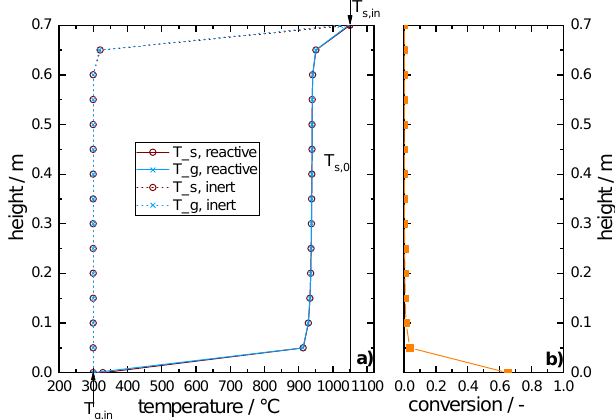
Figure 5. Results for a moving bed with 4g/s Mn-Fe-oxide particles and counter-current air flow ˙ V n of 183L/min operated in steady state. ( a ) Comparison of gas and solid temperature profiles with (solid line) and without (dotted line) reaction. ( b ) Reaction conversion along the bed height for operation in steady